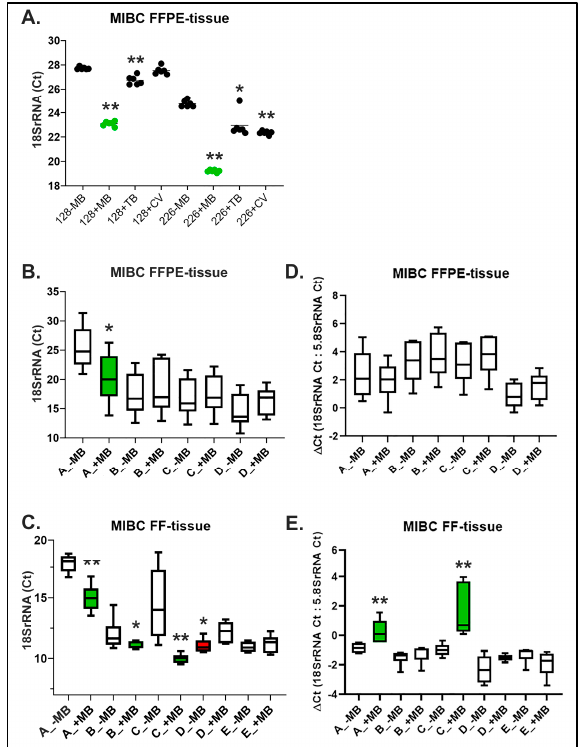
Figure 2. MIBC qPCR 18SrRNA values of RNA isolated from FFPE and FF tissues using different isolation methods. ( A ) Graph shows 18SrRNA Ct values ( Y -axis) from RNA isolated from two FFPE MIBC tissues (#128, #226) using Method A (Table 1). MIBC tissues were microdissected from Methylene blue (MB); Toluidine blue (TB) or Crystal violet (CV) stained samples prior to RNA extraction. Graph shows tissue 128 without ( − ) MB compared to 128 with (+) MB (green dots) ** p = 0.0022 and 128 +TB: ** p = 0.0022; and tissue 226 − MB compared to 226 +MB (green dots): ** p = 0.0022 and 226 +TB: * p = 0.0411 and 226 +CV: ** p = 0.0022, n = 6 technical replicates. ( B ) Each box graph shows 18SrRNA Ct values ( Y -axis) from RNA isolated from six different FFPE MIBC tissues with (+) or without ( − ) MB prior staining using four different isolation methods (A–D) (Table 1); n = 6 technical replicates; * p = 0.0481 Method A (graph in green). All other results either with (+) or without ( − ) MB were not statistically significant. ( C ) Each box graph shows 18SrRNA Ct values ( Y -axis) from RNA isolated from the six different FF patient matched MIBC tissues to FFPE tissues (see B ) above with (+) or without ( − ) MB prior staining using five different isolation methods A–E (Table 1); A − MB to A +MB (green graph), ** p = 0.0043, B − MB to B +MB (green graph), * p = 0.039, C − MB to C +MB (green graph), ** p = 0.0022, D − MB to D +MB (red graph), * p = 0.026; all comparisons to A +MB with B +MB, C +MB, D +MB and E +MB were ** p = 0.0022; all were performed with n = 6 technical replicates. ( D ) Box graphs for isolated RNA from MIBC FFPE tissues after normalization of 18SrRNA with 5.8SrRNA ( ∆ Ct). ( E ) Box graphs for isolated RNA from MIBC FF tissues after normalization of 18SrRNA with 5.8SrRNA ( ∆ Ct). ** p = 0.0065 (A +MB) and ** p = 0.0022 (C